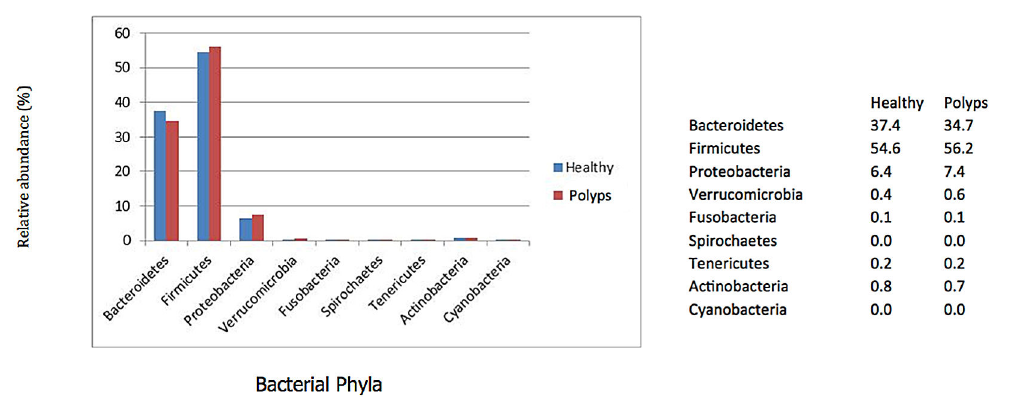
Figure 2. Barplots showing the relative abundances of bacterial phyla in healthy and colon polyps patients’ samples determined by HITChip profiling.